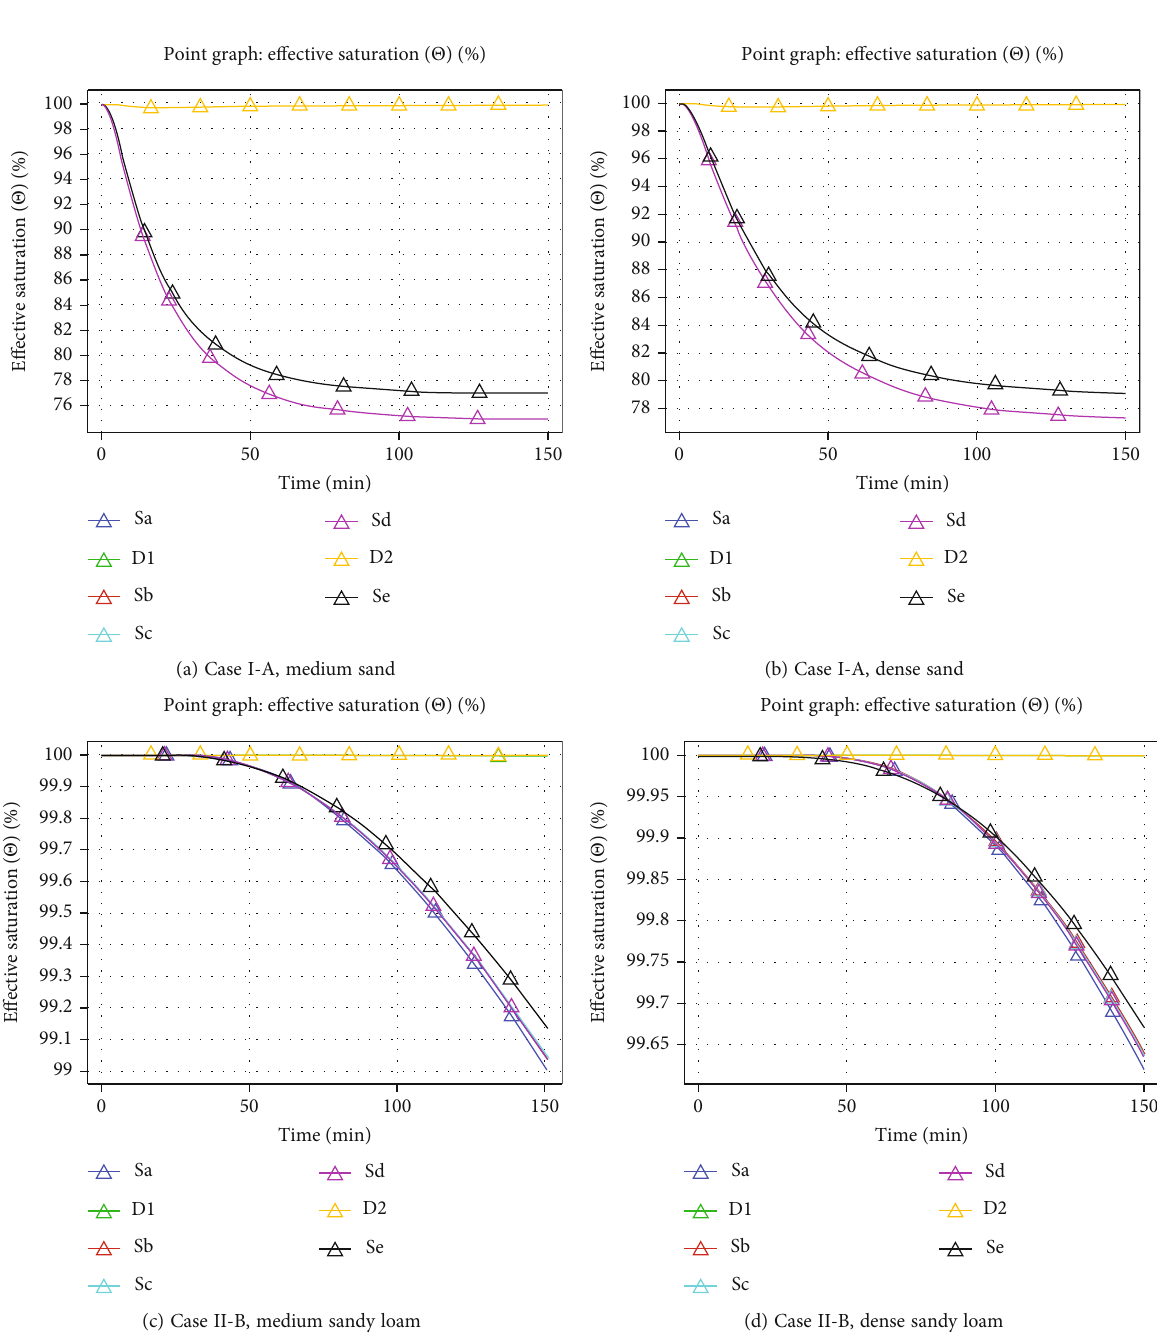
Figure 10: Postirrigation retention history for all soil